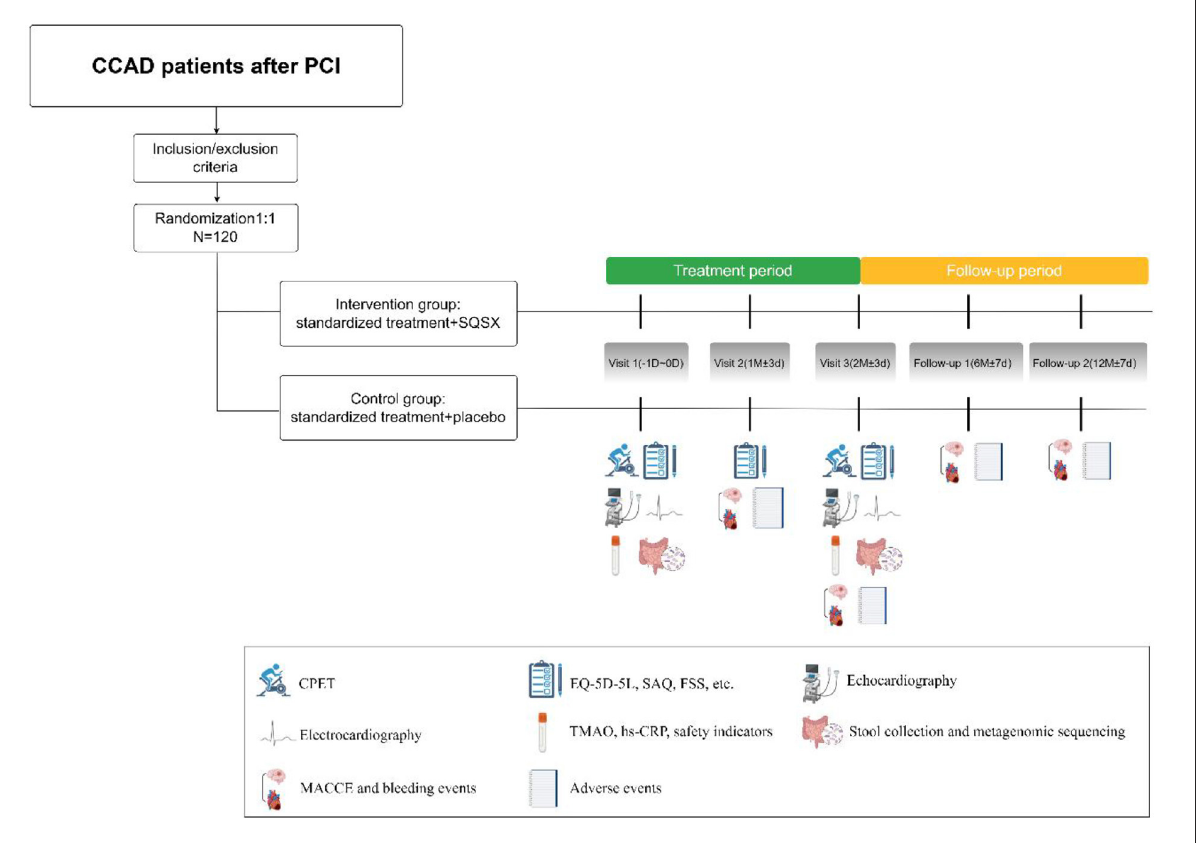
FIGURE1 Flow diagram of the